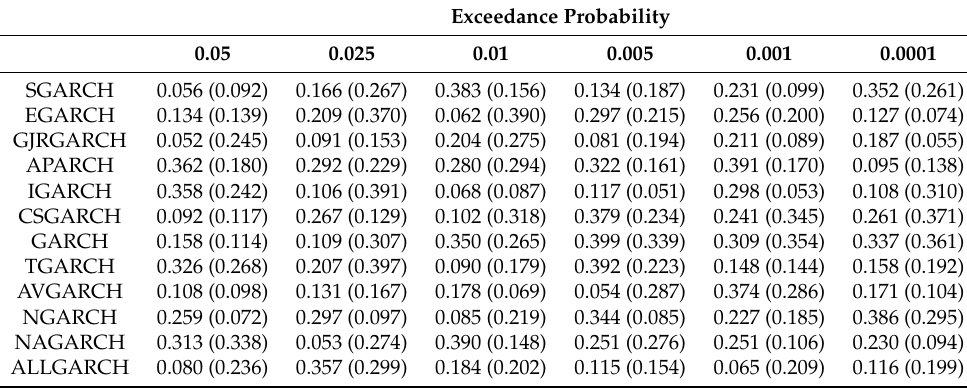
Table 5. p -values of the unconditional (conditional) coverage value at risk exceedance test for the log returns of the exchange rates of Litecoin from 22 June 2014–17 May 2017.